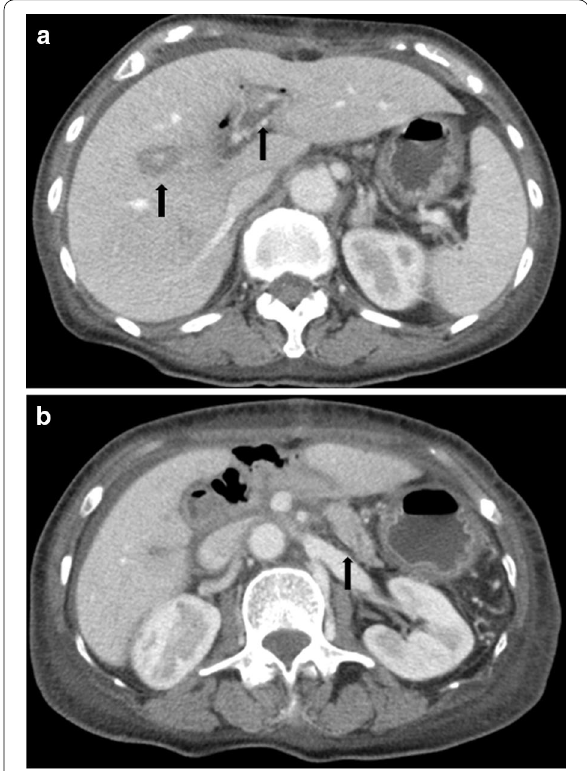
Fig. 2 Postoperative contrast-enhanced computed tomography (CECT) evaluation. a CECT on postoperative day 14 shows intrahepatic portal thrombosis (black arrow) and edema of the Glissonian pedicle, while the superior mesenteric vein anastomosis was patent without thrombosis. b No evidence of intraperitoneal infection, such as pancreatic fistula or bile fistula, was observed. The black arrow indicates the remnant